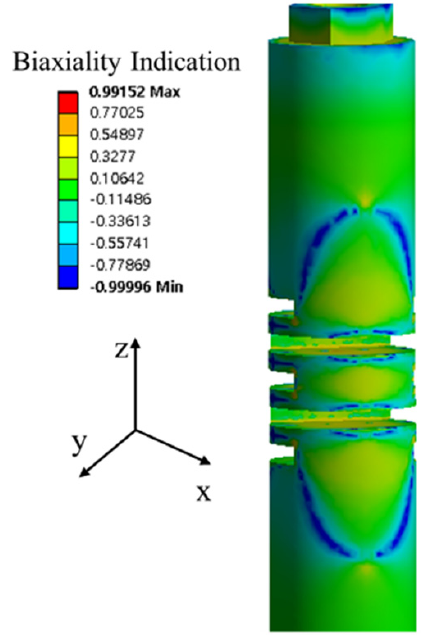
Figure 5. Fatigue analysis result, showing a biaxiality indication.